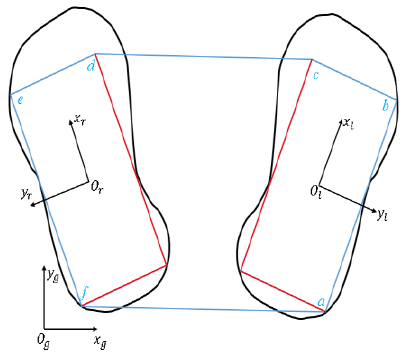
Figure 4. Support area of bipedal